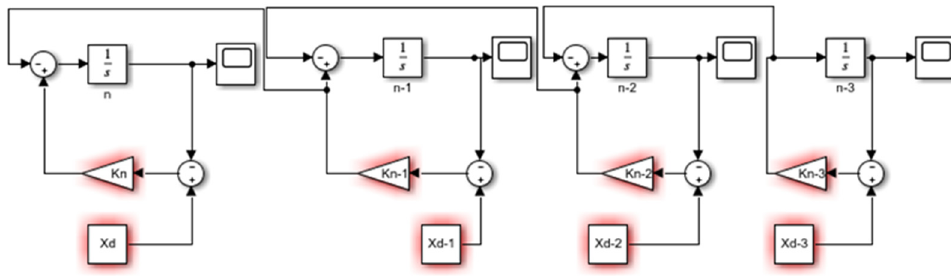
Figure 40. Block diagram of n, state variables.